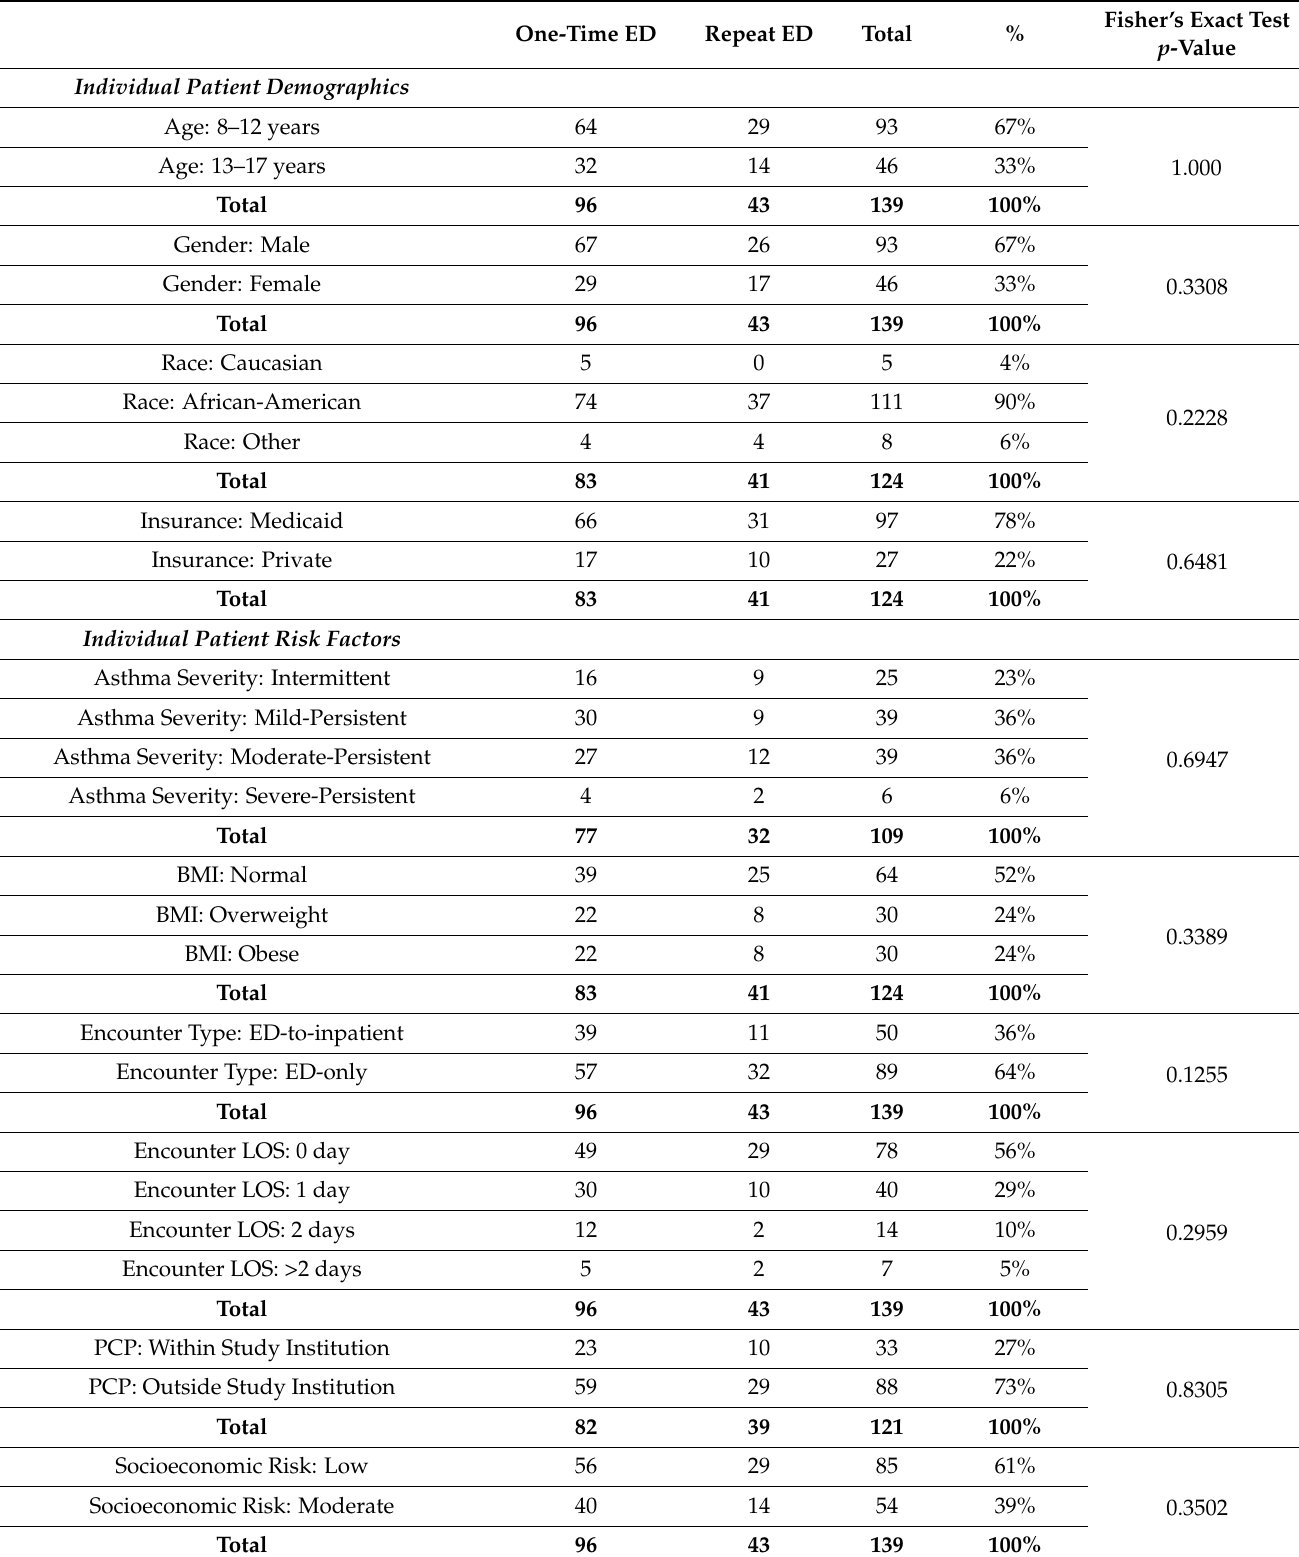
Table 5. Contingency table analysis (Round 2 analysis: 8–17 years). One-Time ED Repeat ED Total %